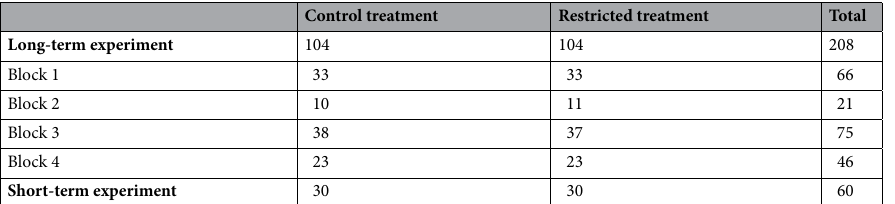
Table 1. The number of focal females that have been used in the different treatments and blocks of the experiments. The final sample sizes available for different analyses (indicated for each specific analysis in Tables 2, 3, 4) may slightly vary from these reference numbers, as a few individuals escaped or died in different phases of the experiment (i.e. during the behavioural assays or in the 1-day oviposition vial). In each analysis, we used the maximum number of available observations. Note that behavioural assays (before and after the treatment) were conducted only on focal females from the long-term